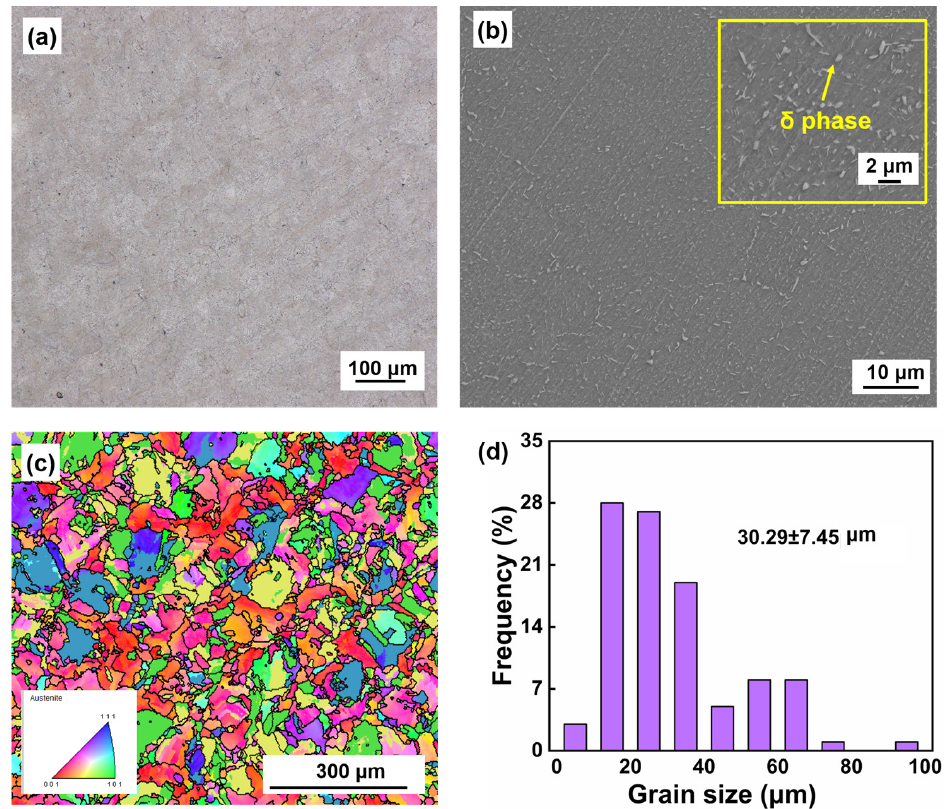
Figure 7. The microstructure of SS samples in X-Y direction: ( a ) OM morphologies; ( b ) SEM image; ( c ) an EBSD inverse-pole figure (IPF) map; ( d ) grain size distributions.